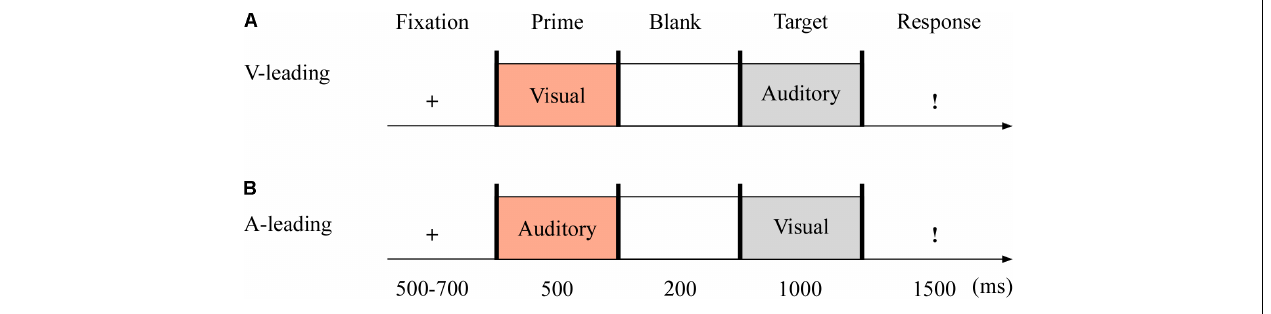
FIGURE 3 | Sampled stimuli and procedure in Experiment 2. The procedure of Experiment 2 showed the sequence of events within a trial for visual-leading mode (V-leading, A ) or auditory-leading mode (A-leading, B